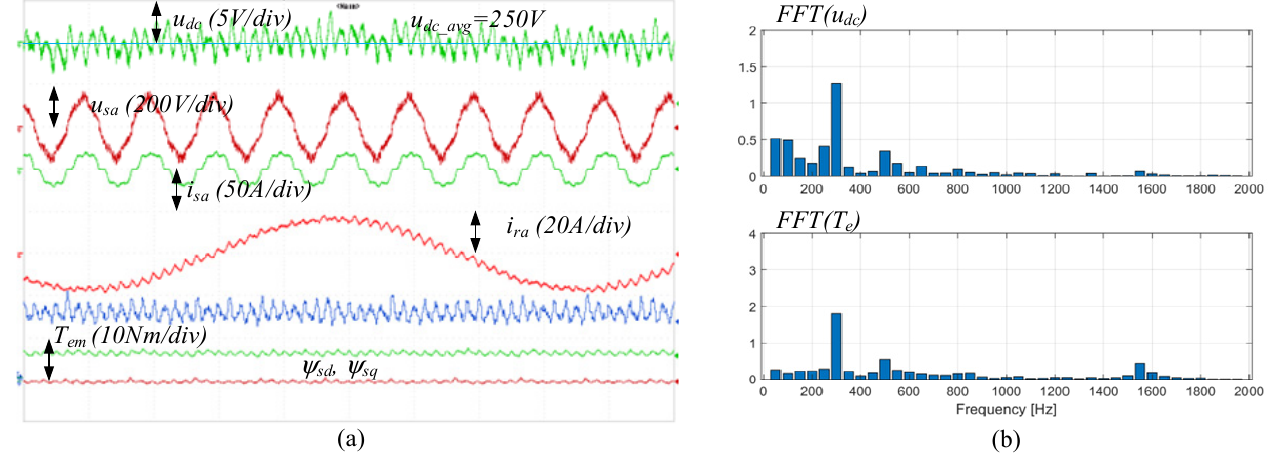
Figure 10. Experimental results of a small-power DFIG-DC system for the classic direct torque control DT Ψ C ( a ) and the FFT results of DC-bus voltage and torque oscillations for this method ( b ).